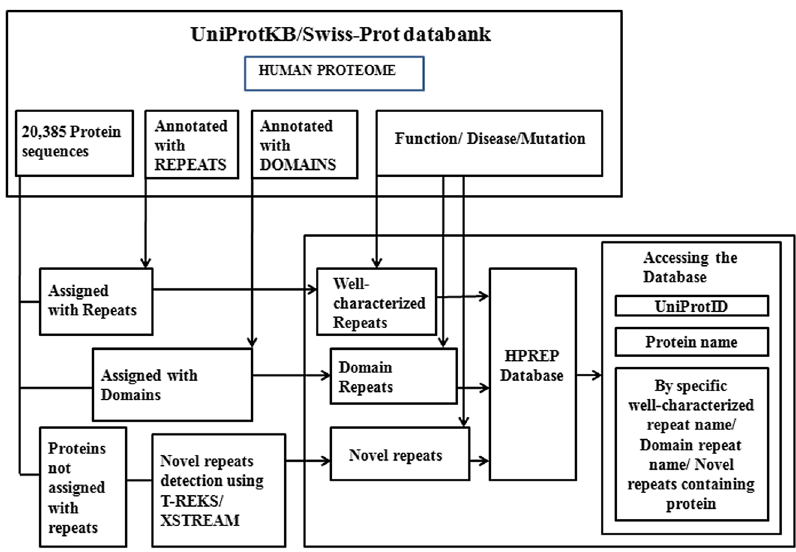
Figure 1: Flowchart shows the generation and accessing of HPREP database. The human protein sequences annotated with well-characterized repeats and domains repeats are collected from UniProtKB/ Swiss-Prot repository and the novel repeats are identified using repeat detection tools. HPREPintegratestheidentified well-characterized, domain and novel repeats of human proteins with the details of functional, mutational and diseases for